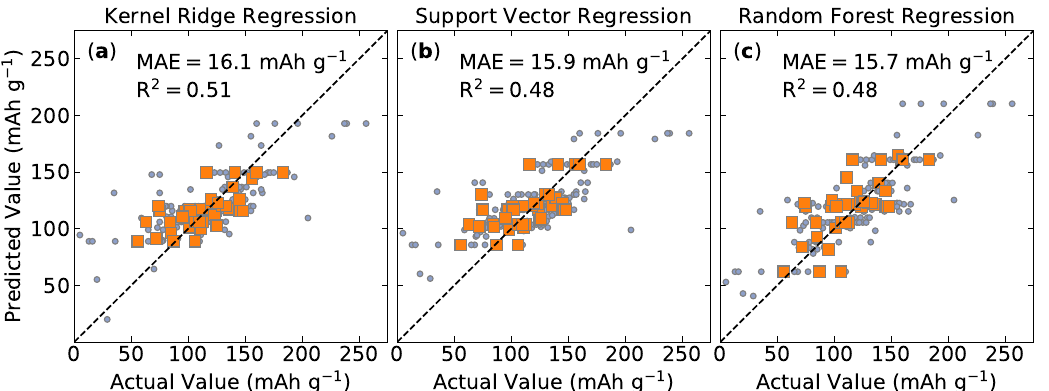
Figure 2. Machine learning prediction results for specific discharge capacity at 25 cycles (mAh g − 1 ) using: ( a ) kernel ridge regression; ( b ) support vector regression; and ( c ) random forests regression. Training (blue circles) and test (orange squares) performance show similar behavior. The mean absolute error (MAE) and coefficient of determination (R 2 ) are shown. Dotted lines are included to help visualize ideal model performance.